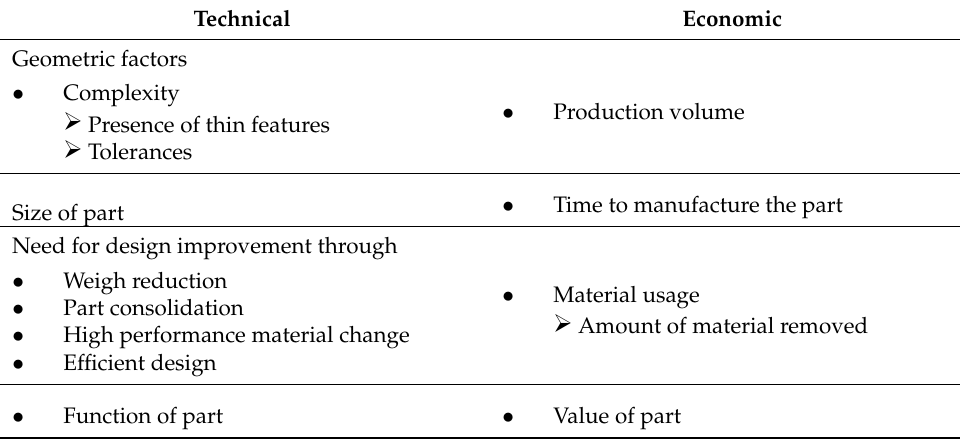
Table 2. Summary of the parameters from the literature.